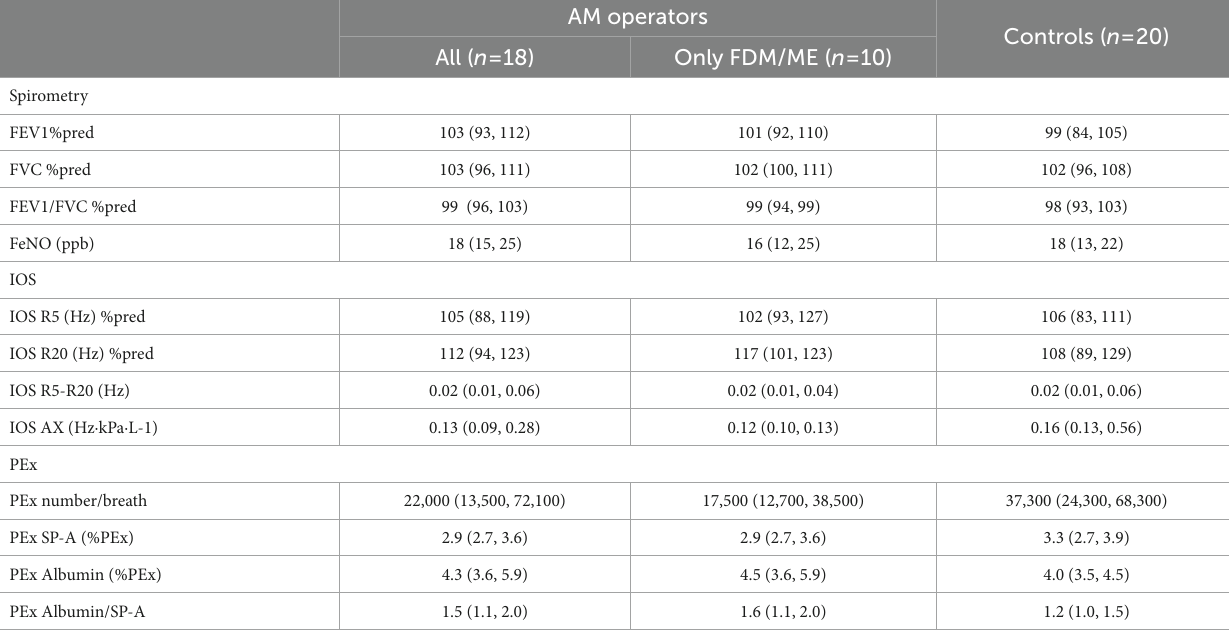
TABLE 2 Results of the lung function tests and breath analyses.